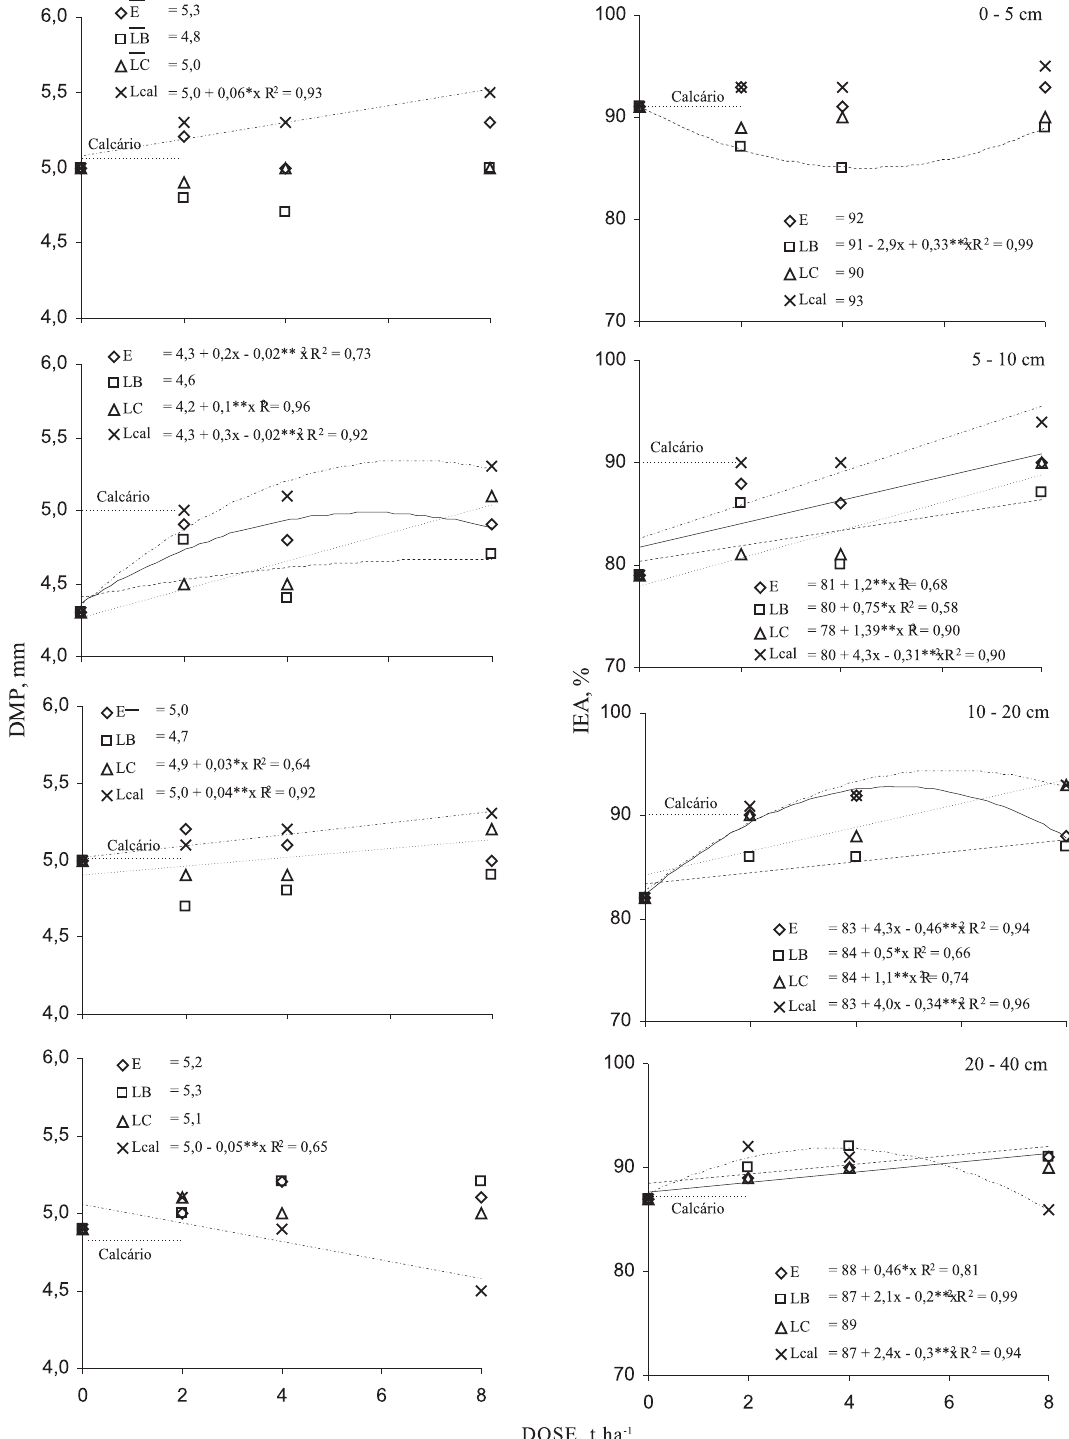
Figura 3. Diâmetro médio ponderado (DMP) e índice de estabilidade de agregados (IEA) em função da aplicação dos resíduos e calcário aos 27 meses após a aplicação. As siglas E, LB, LC e Lcal são escória de aciaria, lodo de esgoto de biodigestor, lodo de esgoto centrifugado e lama cal,